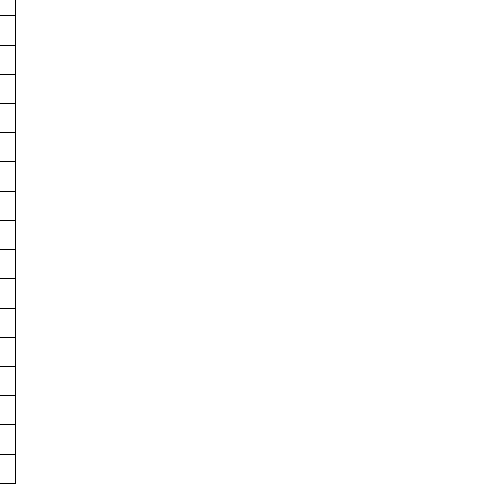
Table 3. Test images with different